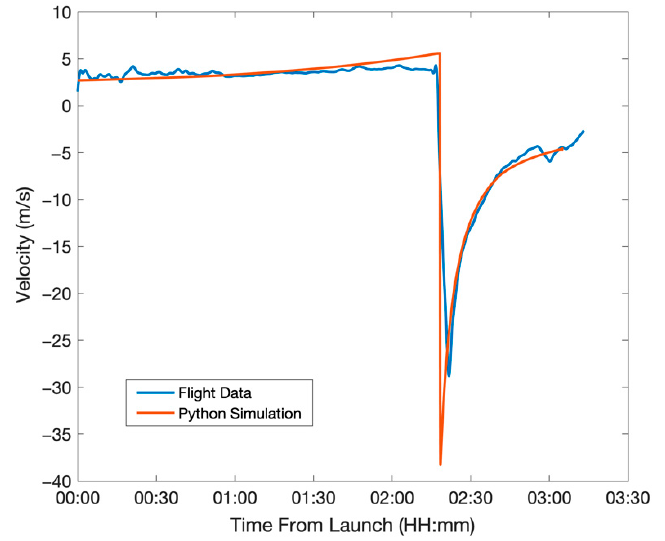
15 of 22 Figure 14. Altitude profiles as a function of time.